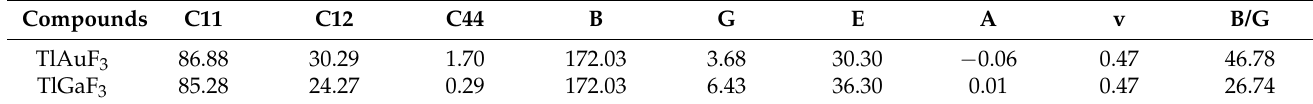
Table 2. Computer-generated mechanical parameters of TlMF 3 (M = Au, Ga), using IRelast package.